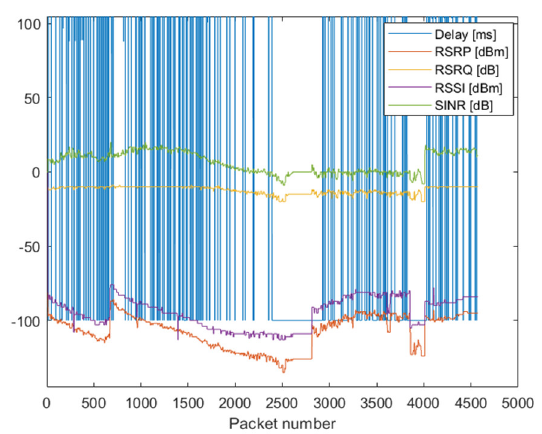
Figure 5. Enlarged plots from Figure 4.